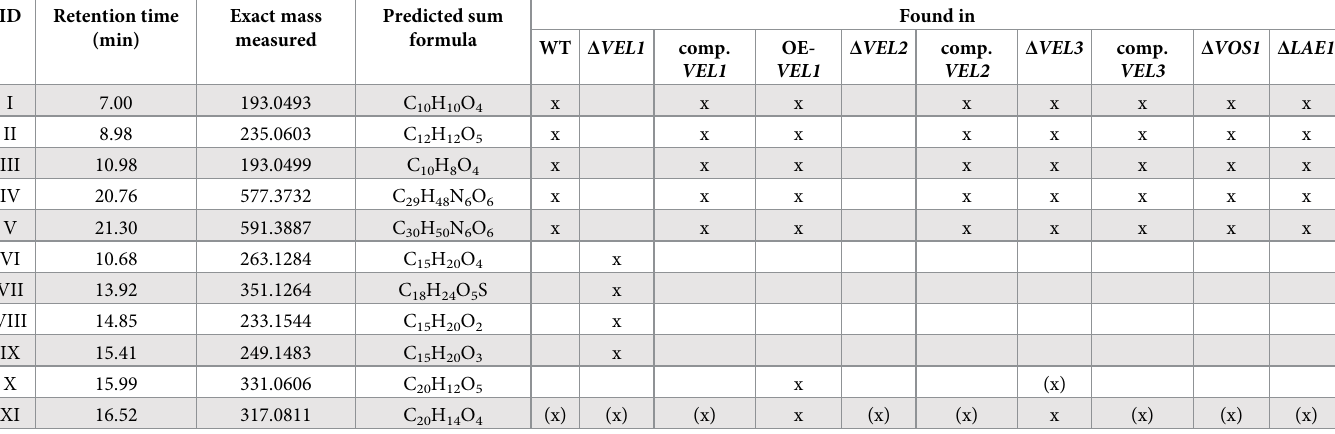
Table 2. Metabolites detected by LC/MS in different V . dahliae strains.